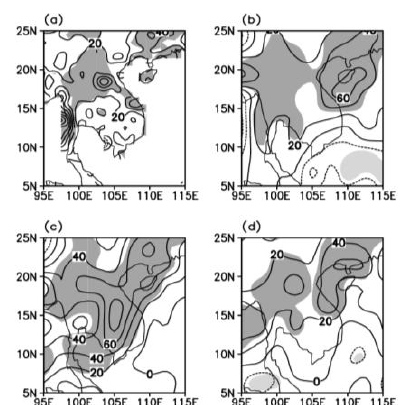
Figure 3. Epochal differences (2002–1994 minus 1982–1993) in summer rainfall based on the (a) GPCC, (b) CMAP, (c) GPCP and (d) NOAA Recon datasets. Values exceeding the 95% confidence level are shaded.